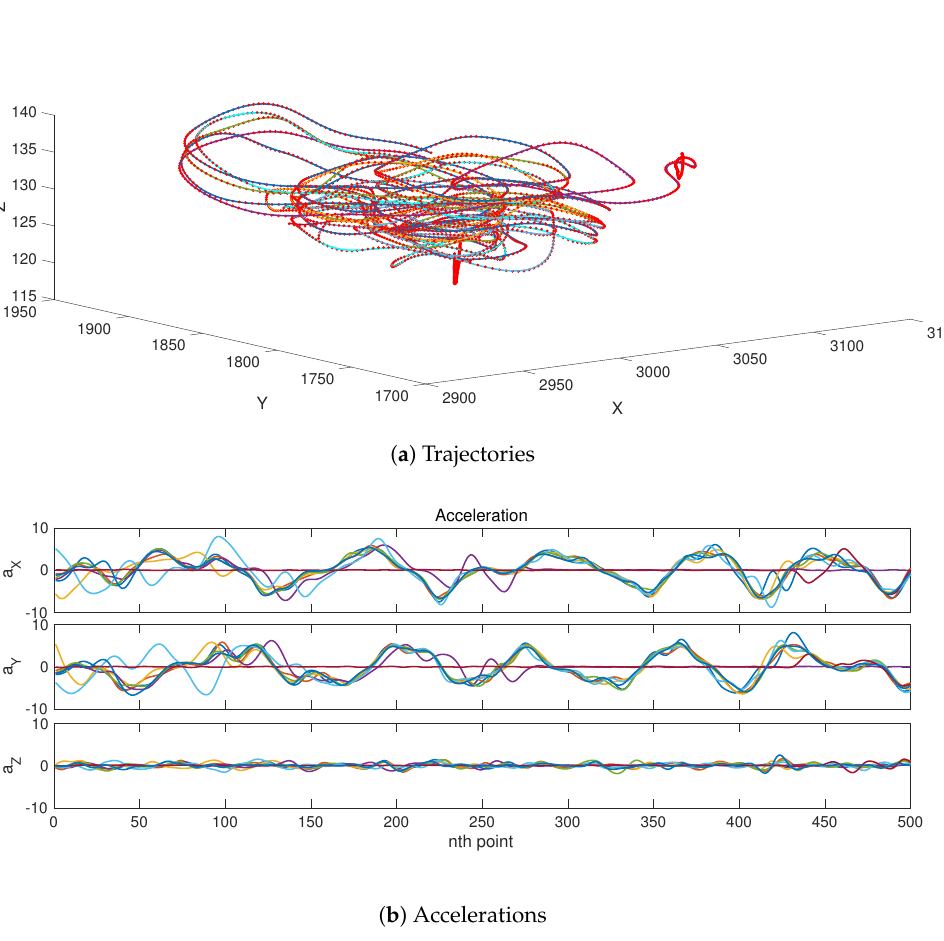
Figure 1. Shadowing filter applied to GPS data from a flock of pigeons. The shadowing filter successfully tracks the eight pigeons. In this demonstration, we refer to our previous works [12,13]. In ( a ), we track the trajectories of the eight pigeons (the coloured solid lines) from the GPS signals (red dots). In ( b ), we use the tracking algorithm to estimate the corresponding acceleration profiles for each pigeon (colours refer to different pigeons).